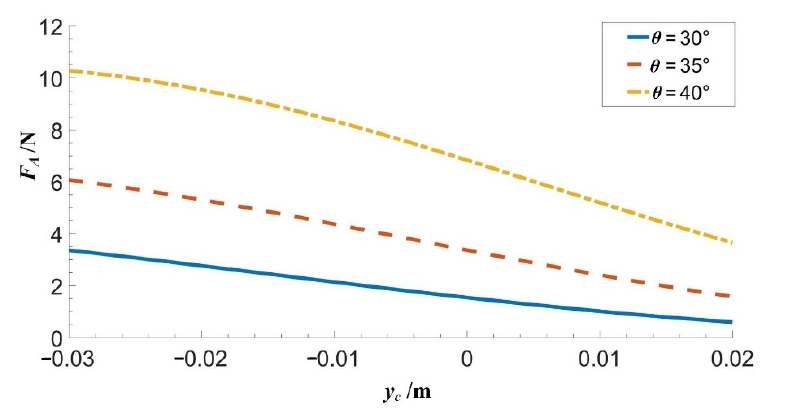
Figure 17. Force F A on the left flexible finger at 30 ◦ , 35 ◦ and 40 ◦ .